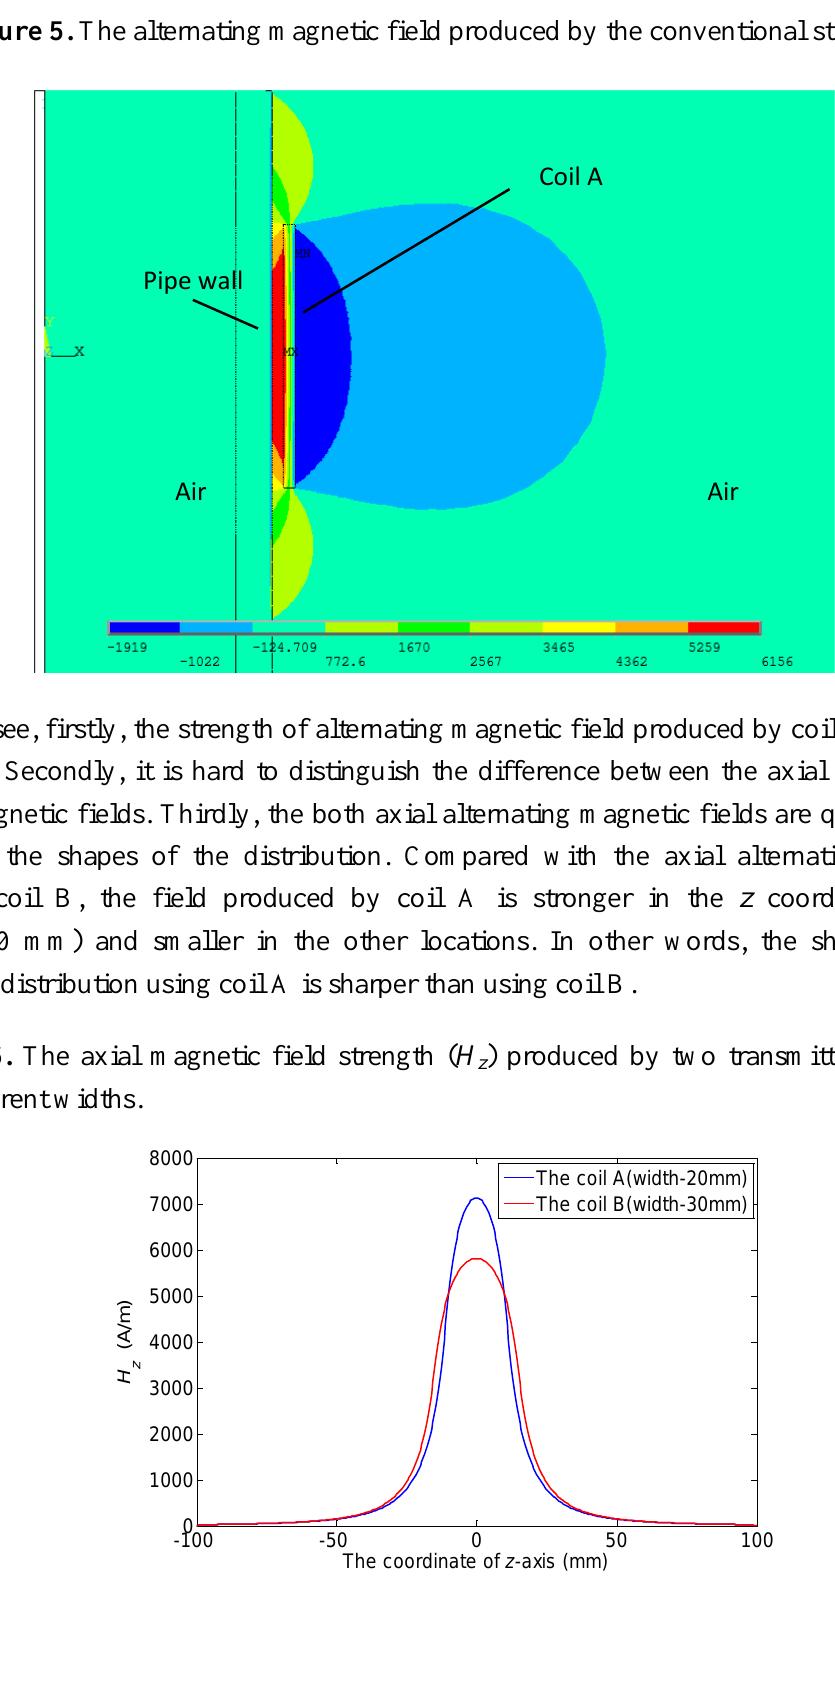
Figure 5. The alternating magnetic field produced by the conventional structure.